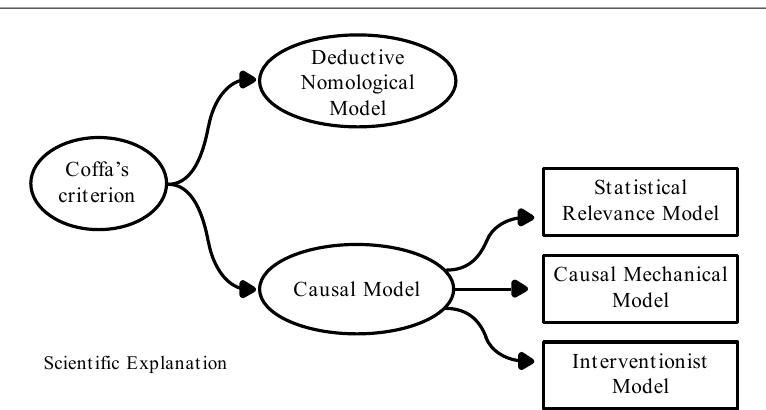
Figure 2. Schematic representation of the classic classification of scientific explanation, according to Coffa’s criterion.